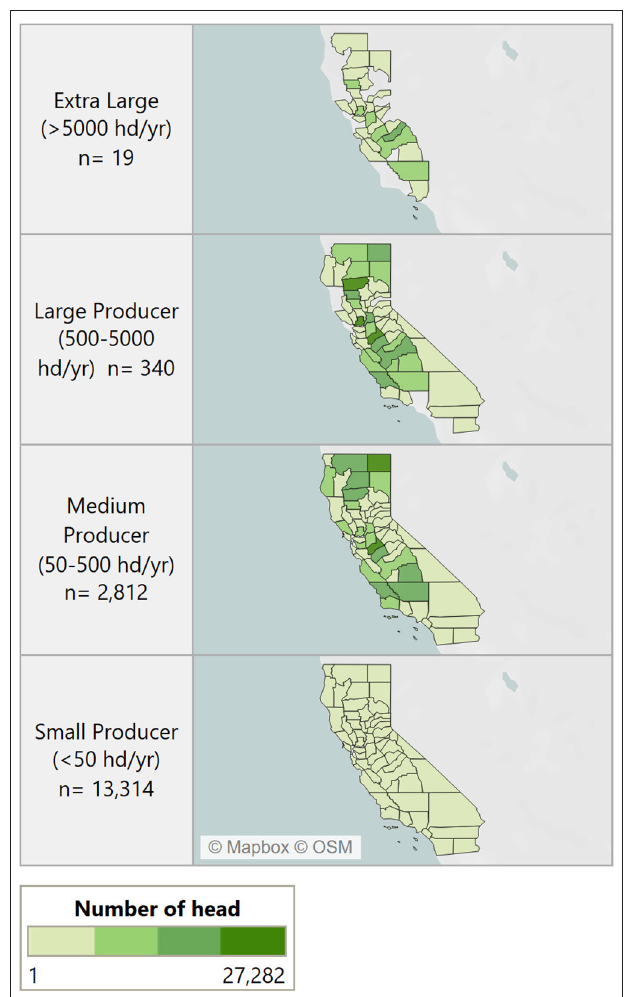
FIGURE 2 | Origin of all beef cattle from California (by county) moved from grazing lands by producer size (2017).